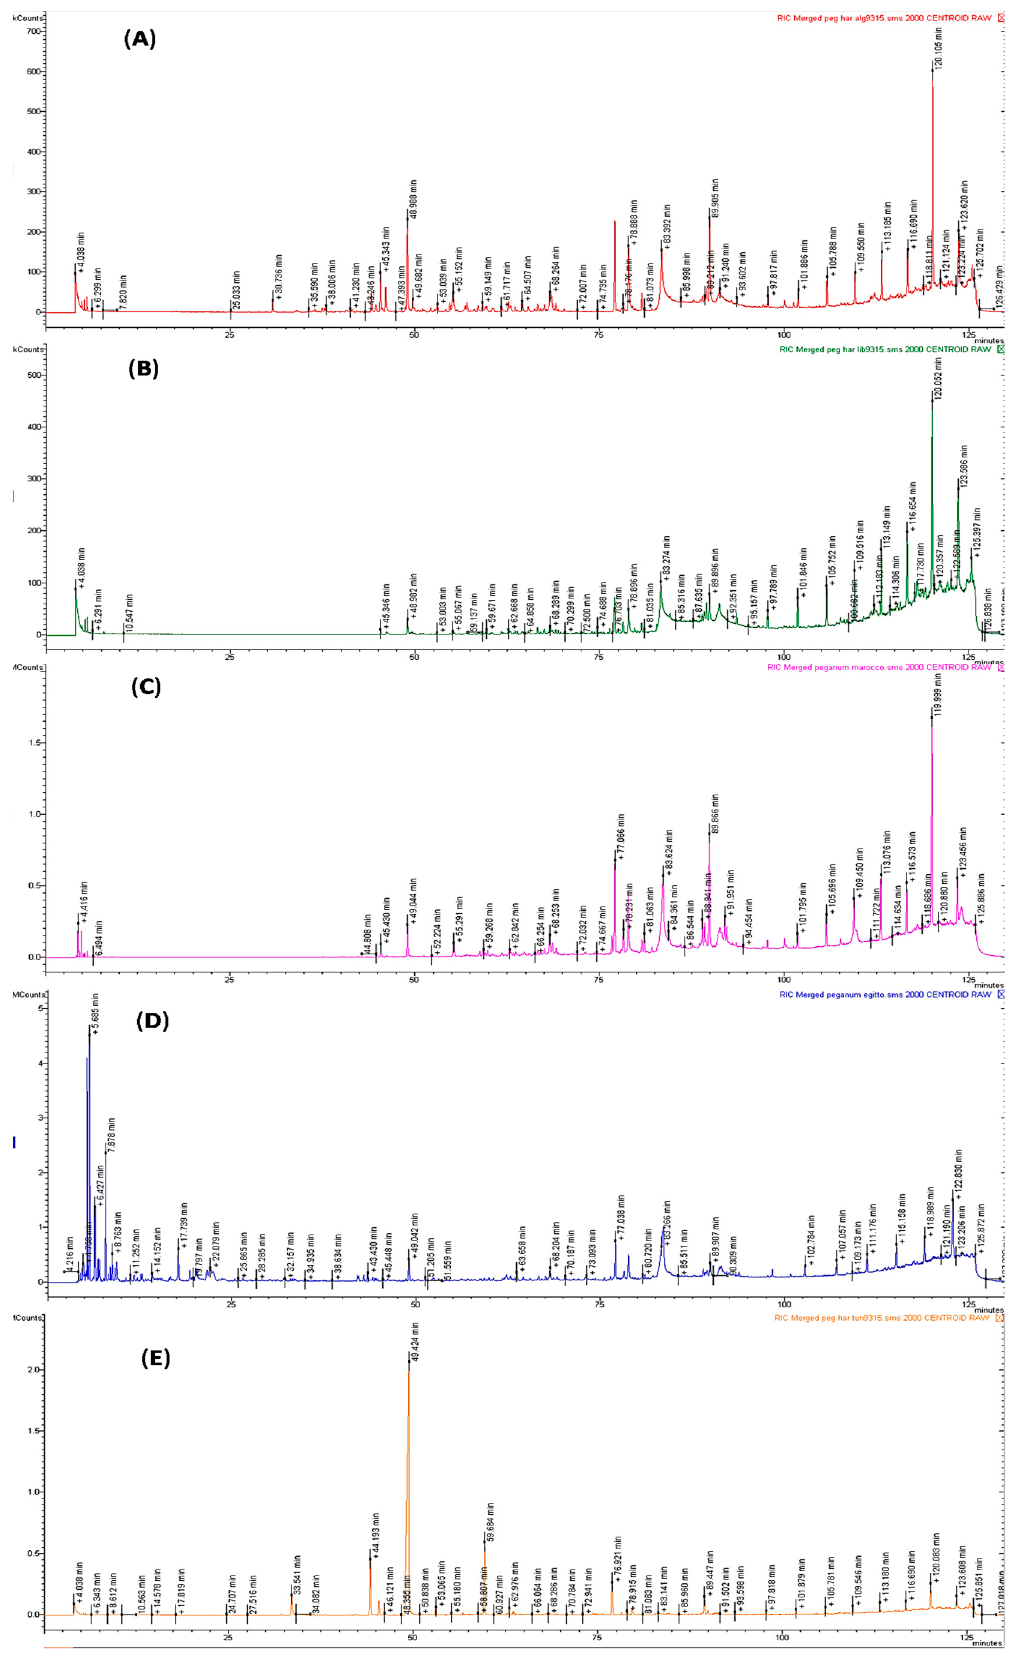
Figure 1. The Gas Chromatography (GC) profile of P. harmala essential oil from Algeria ( A ); Egypt ( B ); Libya ( C ); Morocco ( D ) and Tunisia ( E ).